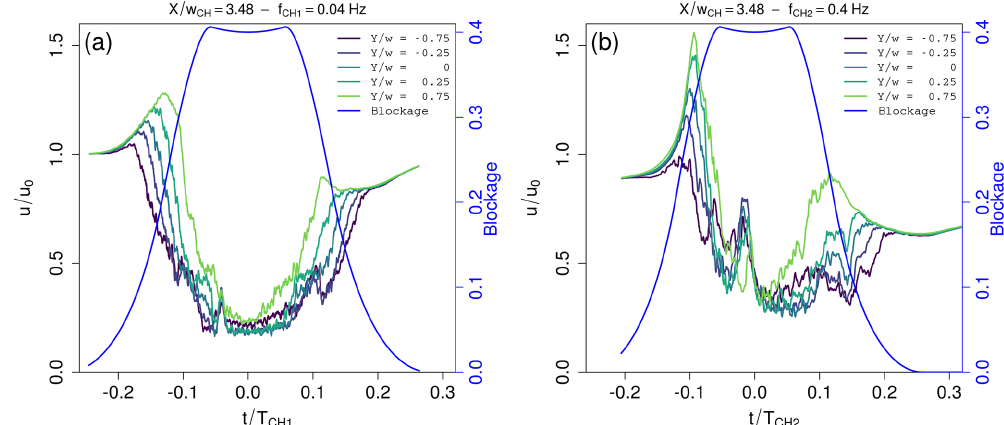
Figure 12. Span-wise evolution of the smoothened average inverse gust at X/w CH = 3 . 475 with respect to the chopper blade position. The inverse gust as measured by the respective sensor is plotted over the normalized time, where t/T CH = 0 indicates that the chopper blade is aligned horizontally in the inlet, and the blockage is added in blue with the blue axis on the right side. The chopper frequencies are = 0 . 04Hz and (b) f = 0 . (a) f CH CH 2 1